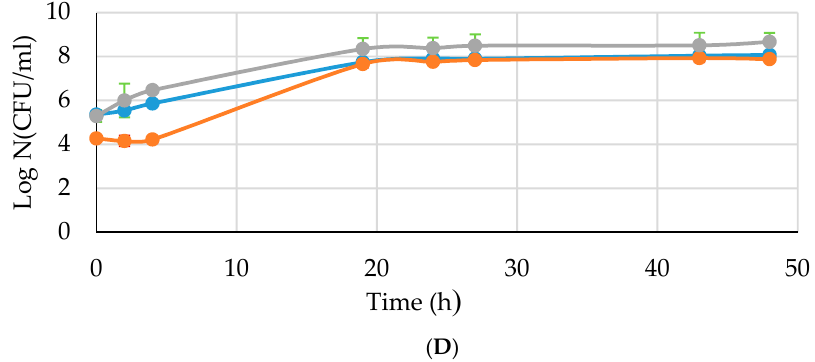
Figure 1. Growth curve of the strains 2, 7, 47 and S122 in synthetic medium. Symbols indicate different samples as blue circle (control), orange circle (temperature-pretreated) and grey circle (ethanol-pretreated). ( A ) S. cerevisiae 2; ( B ) S. cerevisiae 7; ( C ) S. cerevisiae 47; ( D ) S. cerevisiae S122. Ethanol was detected from 19 h onward, for all strains and treatments. The effects of different pretreatments on glucose, fructose and ethanol concentrations were evaluated in three different periods, expressed as 0–19, 0–24 and 0–48 h: 19 h was the first time in which ethanol appeared, 24 h the middle of the fermentation process and 48 h the moment in which the fermentation stopped. These three periods were formed by taking the absolute differences between glucose, fructose and ethanol levels at the beginning of fermentation and the considered time, as expressed in Table 1. Table 1. Glucose and fructose consumption as well as ethanol concentrations (g/L) at different intervals during fermentation performed by S. cerevisiae strains coded 2, 7, 47 and S122 without (control) or with pretreatments (temperature or ethanol). Data presented as mean ± standard deviation, two replicates were analyzed.